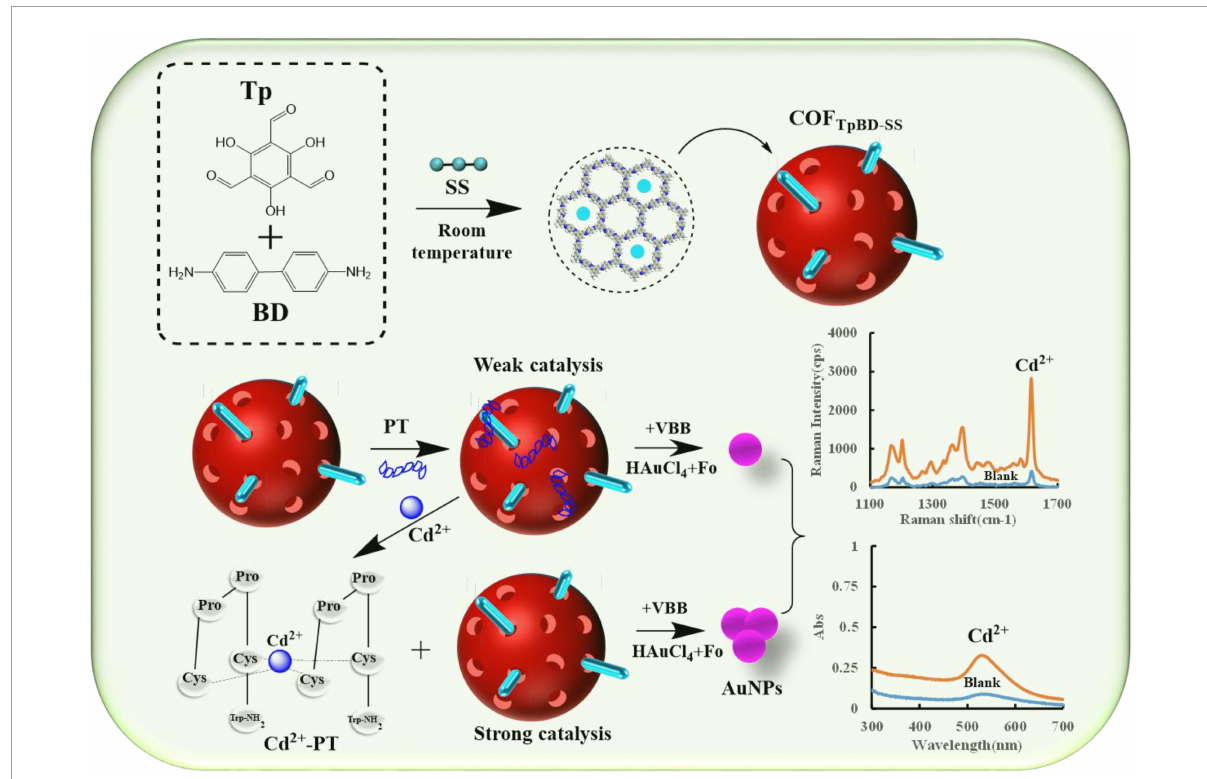
FIGURE1 Schematic diagram of the SERS/Abs detection for Cd 2 + coupled COF TpBD - SS catalysis amplification via PT.